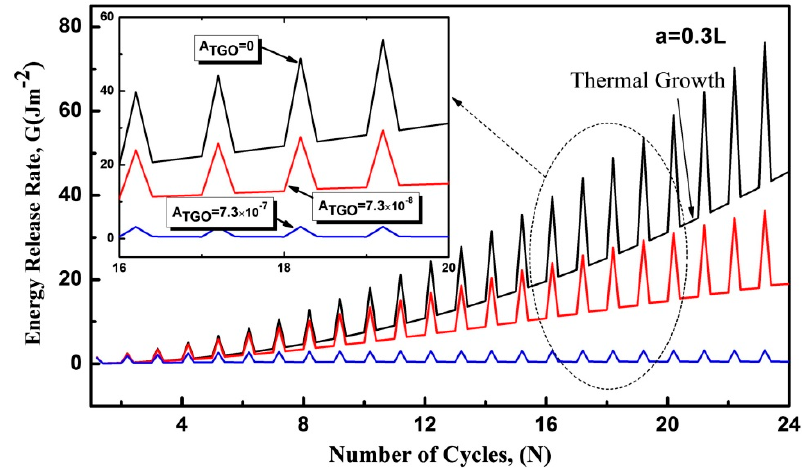
Figure 4. The variation of energy release rate with thermal cycling for different thermally grown oxide (TGO) creep [46].